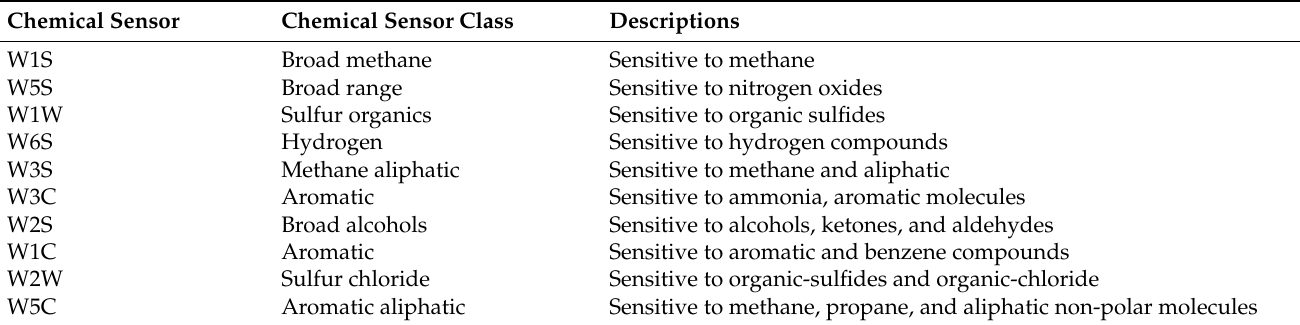
Table 5. Information on 10 chemical sensor array